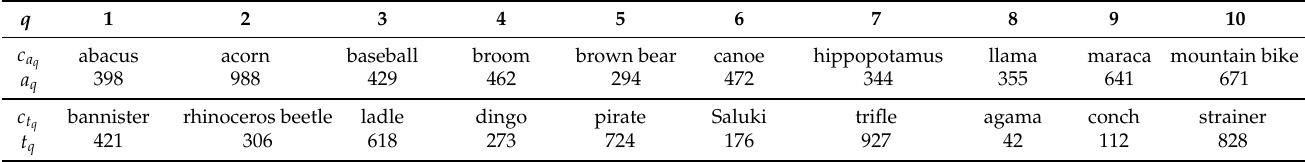
Table 1. For 1 ≤ q ≤ 10, the second row gives the ancestor category c a among the categories of ImageNet (Mutatis mutandis for the target categories, third